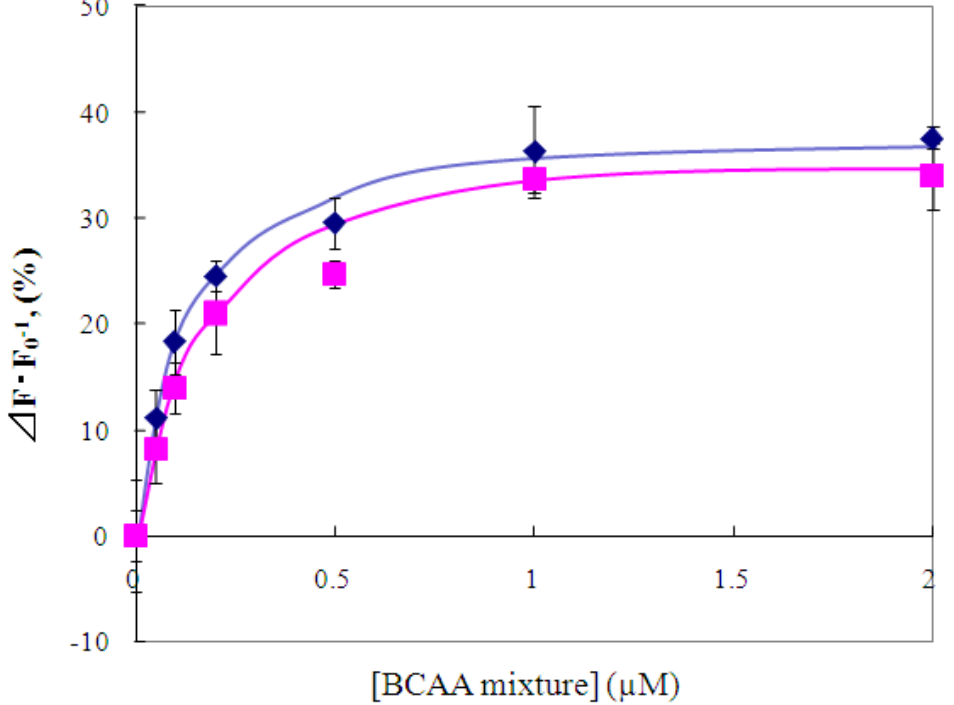
Figure 6. Correlation between fluorescence intensity change of Gln149Cys-MIANS and BCAA mixtures. The fluorescence intensity changes (at 434 nm) of Gln149Cys-MIANS at a final concentration of 0.4 µM were determined at different concentrations of BCAA mixtures; mixture 1) Leu:Ile:Val = 29:15:56 (lozenge ♦ ), mixture 2) Leu:Ile:Val = 28:22:50 (square ■ ). Error bars indicate SD ( n